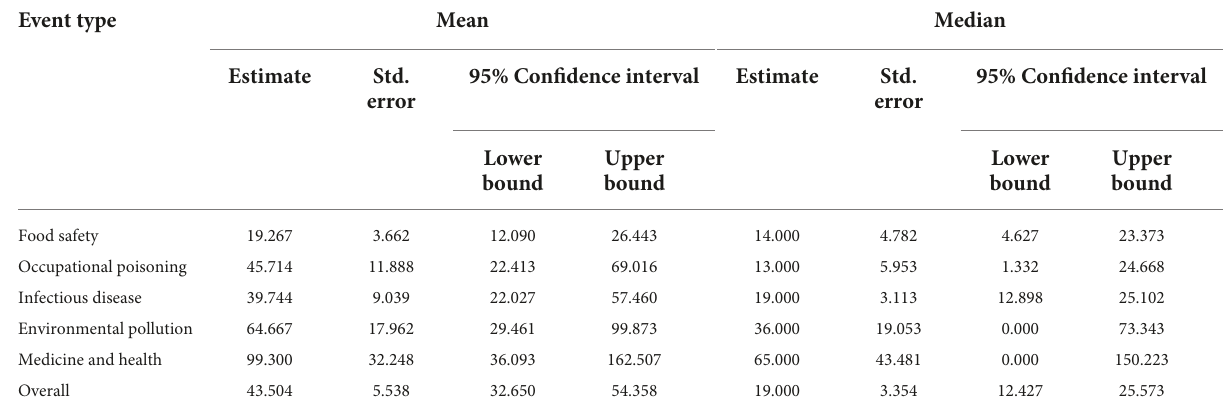
TABLE 4 Descriptive statistics of event type.